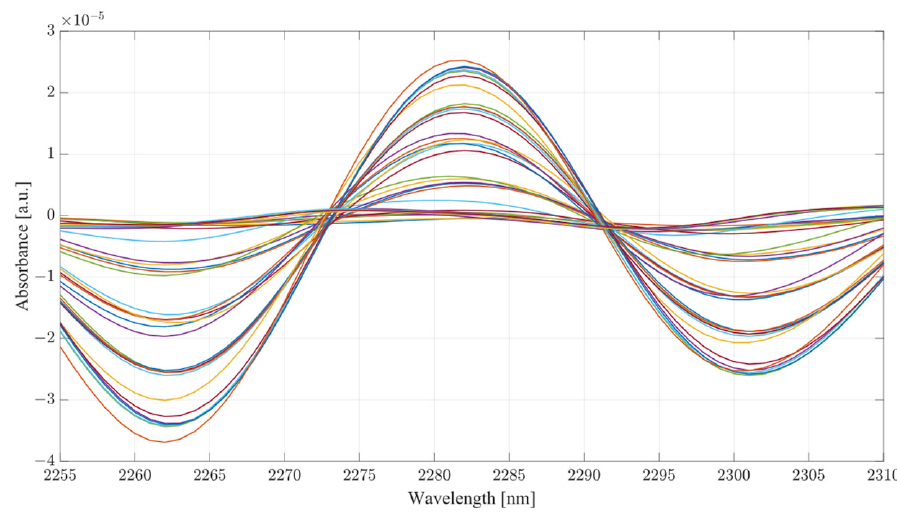
Figure 10. Peaks of 2262 and 2302 nm in water mixtures.